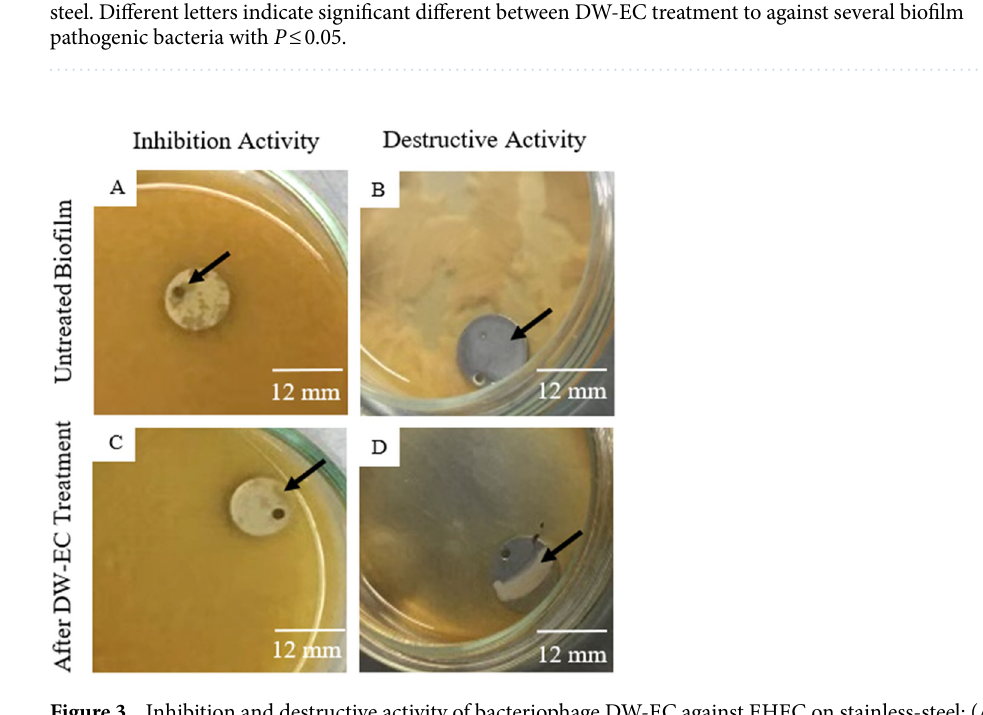
Figure 3. Inhibition and destructive activity of bacteriophage DW-EC against EHEC on stainless-steel: ( A , B ) untreated biofilm and ( C , D ) biofilm treated with DW-EC treatment. Black arrows indicate biofilm.